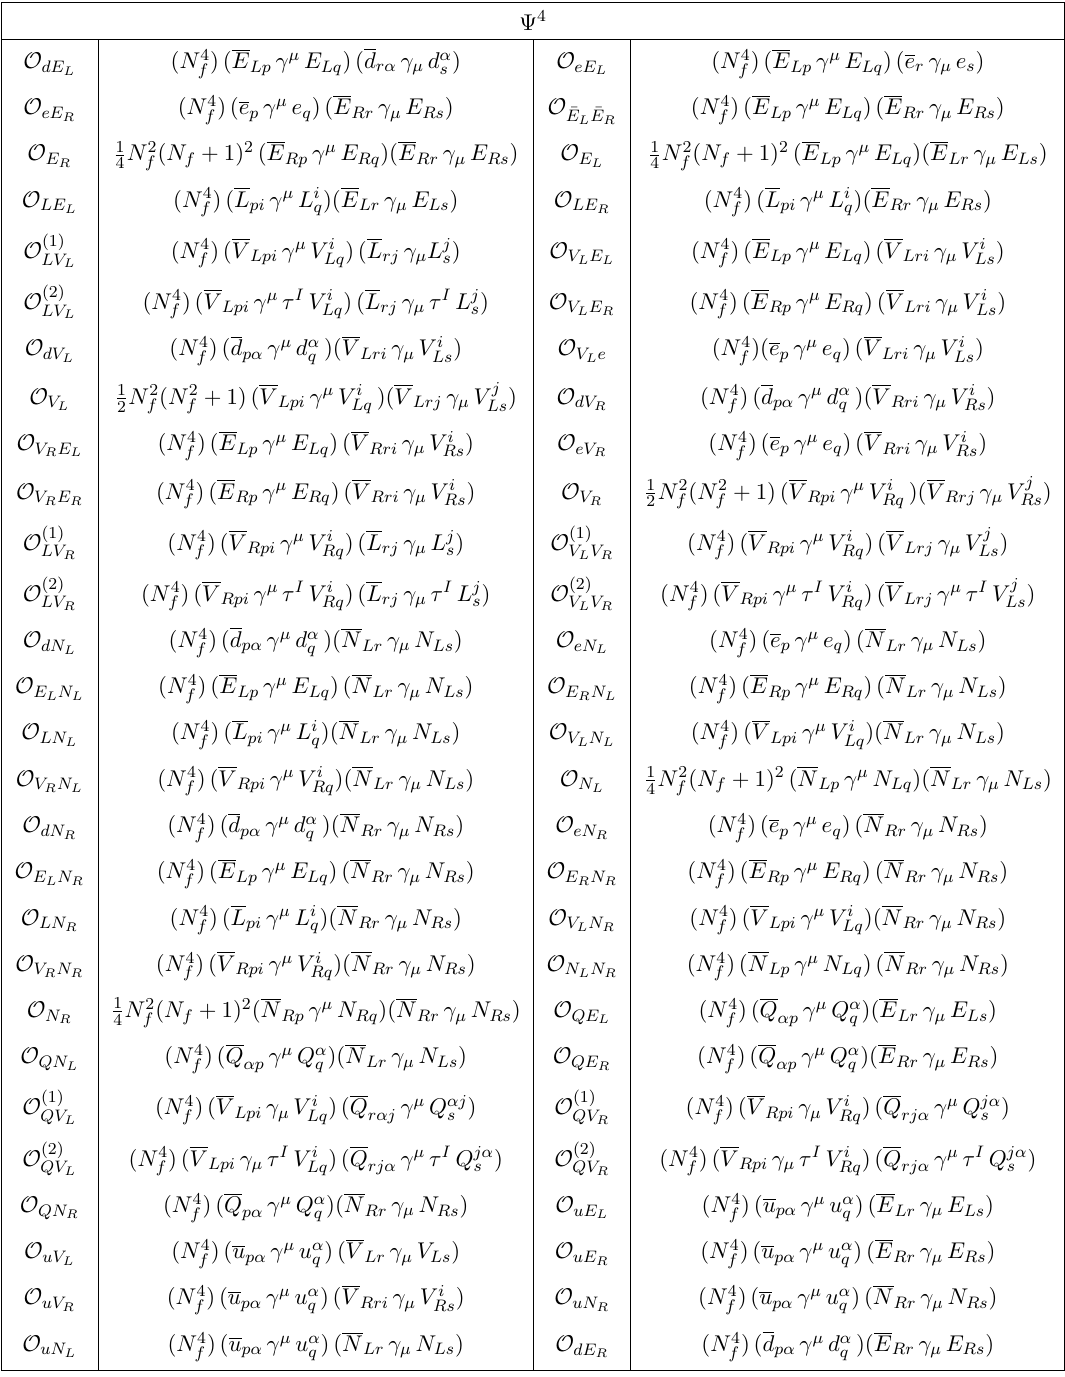
Table 12 . SM extended by Vector-like Leptons ( V L,R , E L,R , N L,R ): additional operators of di- mension 6. i, j and α are the SU(2) and SU(3) indices respectively. p, q, r, s = 1 , 2 , · · · , N f are the flavour indices. τ I ( I = 1 , 2 , 3) is the SU(2) generator. All the operators in this table conserve the lepton and baryon numbers (∆ B = 0 , ∆ L = 0)